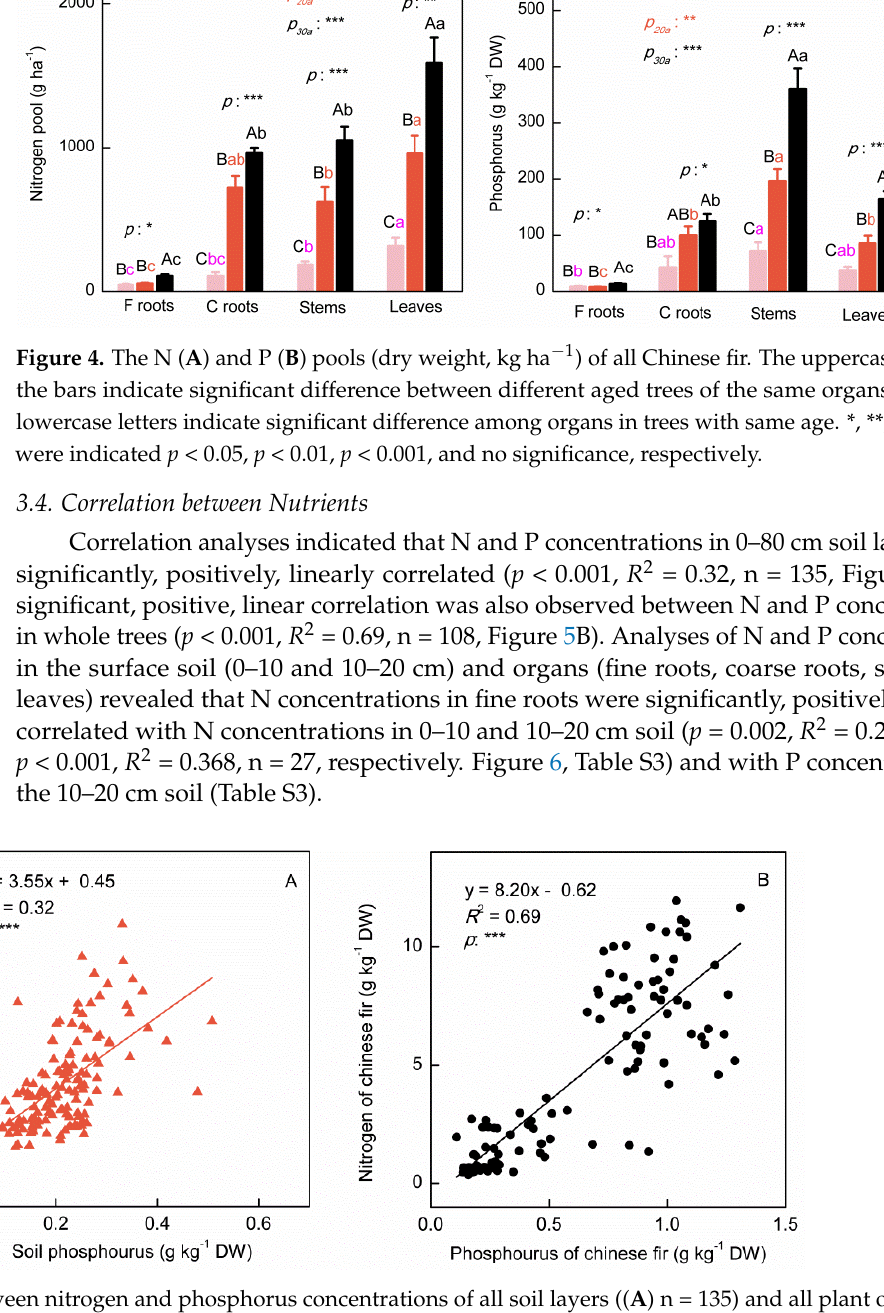
Figure 6. Correlation between 0–10 (red triangle) and 10–20 cm (black dot) soil nitrogen concentra- tion and fine roots’ nitrogen concentrations (n = 27). ** and *** were indicated p < 0.01 and p < 0.001, respectively. 4. Discussion 4.1. Spatial and Temporal Variation in Soil N and P Content Our results indicated that total N concentrations in the 0–80 cm soil (Figure 2A), and total P concentrations in the 0–40 cm soil (Figure 2B) of all plantations decreased with increasing soil depth. A similar pattern was reported in Caragana microphylla Lam. [26], Chinese fir ( Cunninghamia lanceolata ) [27,28], and black locust [29] of the change of soil organic matter was because of the decrease of litter and roots with the increase of soil depth [29]. Additionally, climatic factors, such as temperature and moisture, and organ- isms [30] are more beneficial to litter decomposition in the upper soil layer than in the deeper soil layers, which leads to N and P enrichment in the surface soil layer. Moreover, N and P in the deeper soil layers result mainly from leaching of surface soil layers and geologic N and P, whereas leaching of N and P decreases with increasing soil depth. As a result, total N and P were more noticeably concentrated in surface soils and decreased with increasing soil depth.